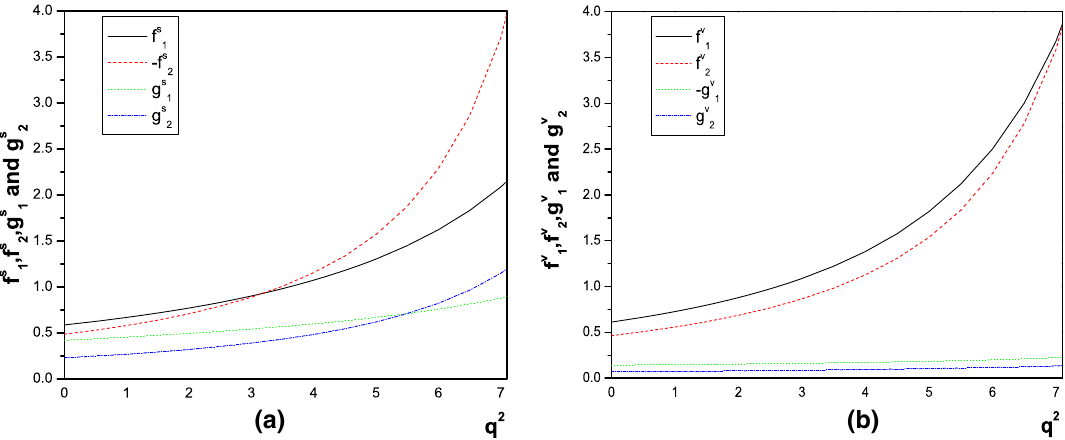
Fig. 2 The dependence of form factors f s and g v on q 2 ( b 2